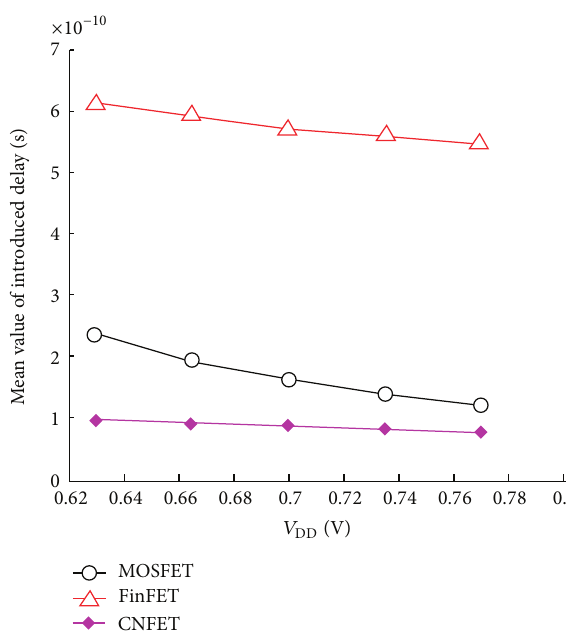
Figure 11: Delay (pulse width) introduced by proposed buffered delay model utilizing different technologies and its variations with the supply voltages.